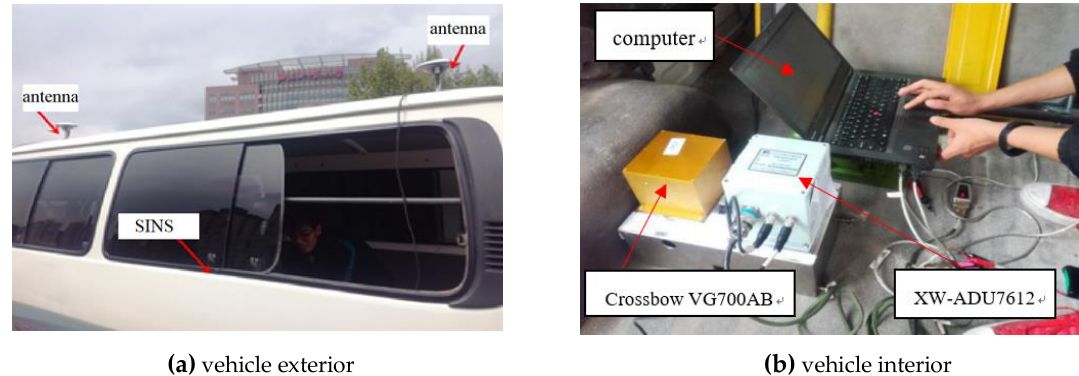
Figure 8. Installation diagram of the experimental facilities.